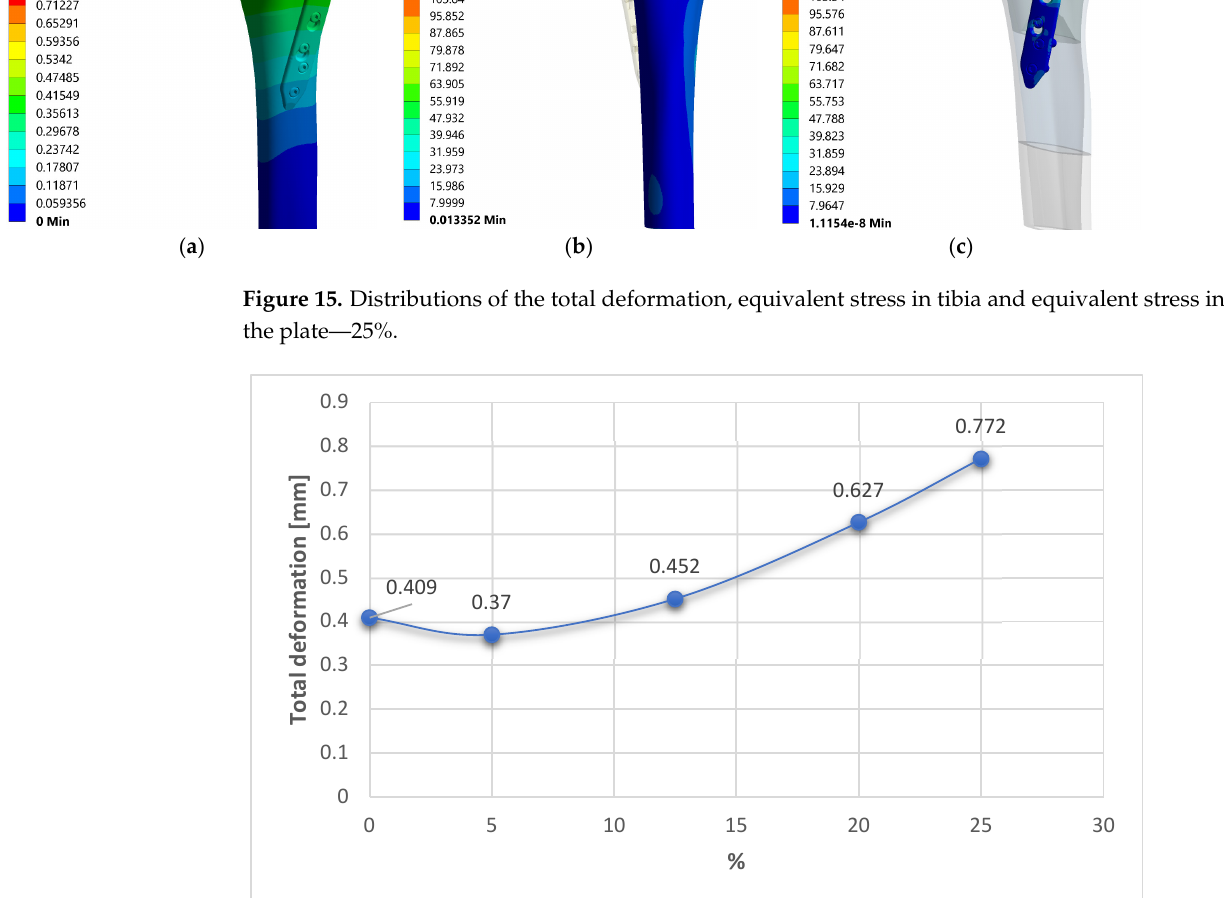
Figure 16. Variation in the total deformation related to the overcorrection positions.